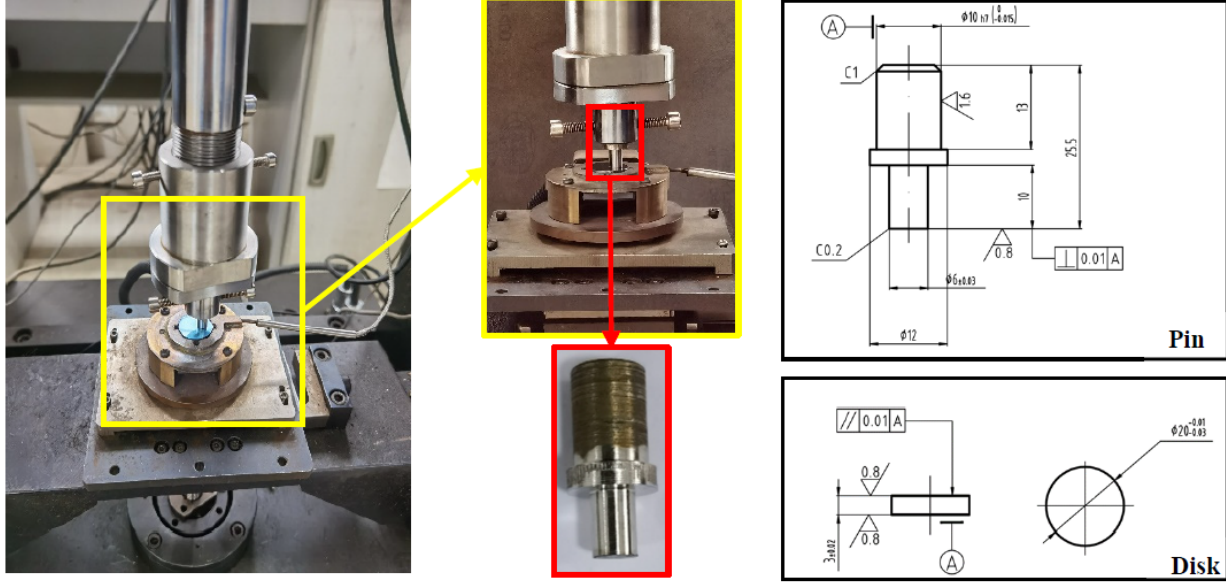
Figure 2. High-speed reciprocating friction and wear test machine (tribometer) and wear sample Figure 2. dimensions.